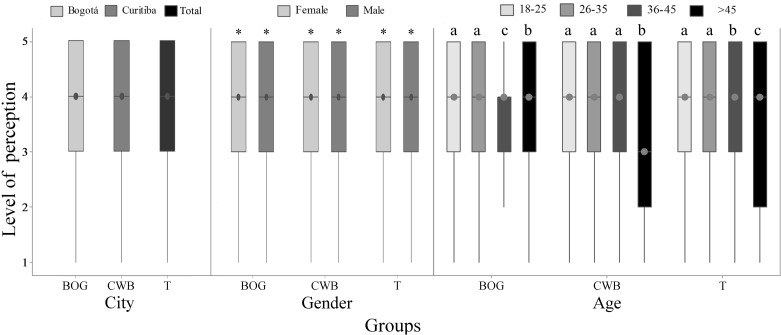
Perception of fish pain (Q6) by 782 citizens of Bogotá and Curitiba, 2014/2015.Data for city, gender and age; 1 = none and 5 = maximum; (BOG) represents data from Bogotá, (CWB) data from Curitiba and (T) the total data; the asterisk indicates gender difference (P<0.05, Mann-Whitney); letters indicate age difference (P<0.05, Kruskal-Wallis and Dunn Test).